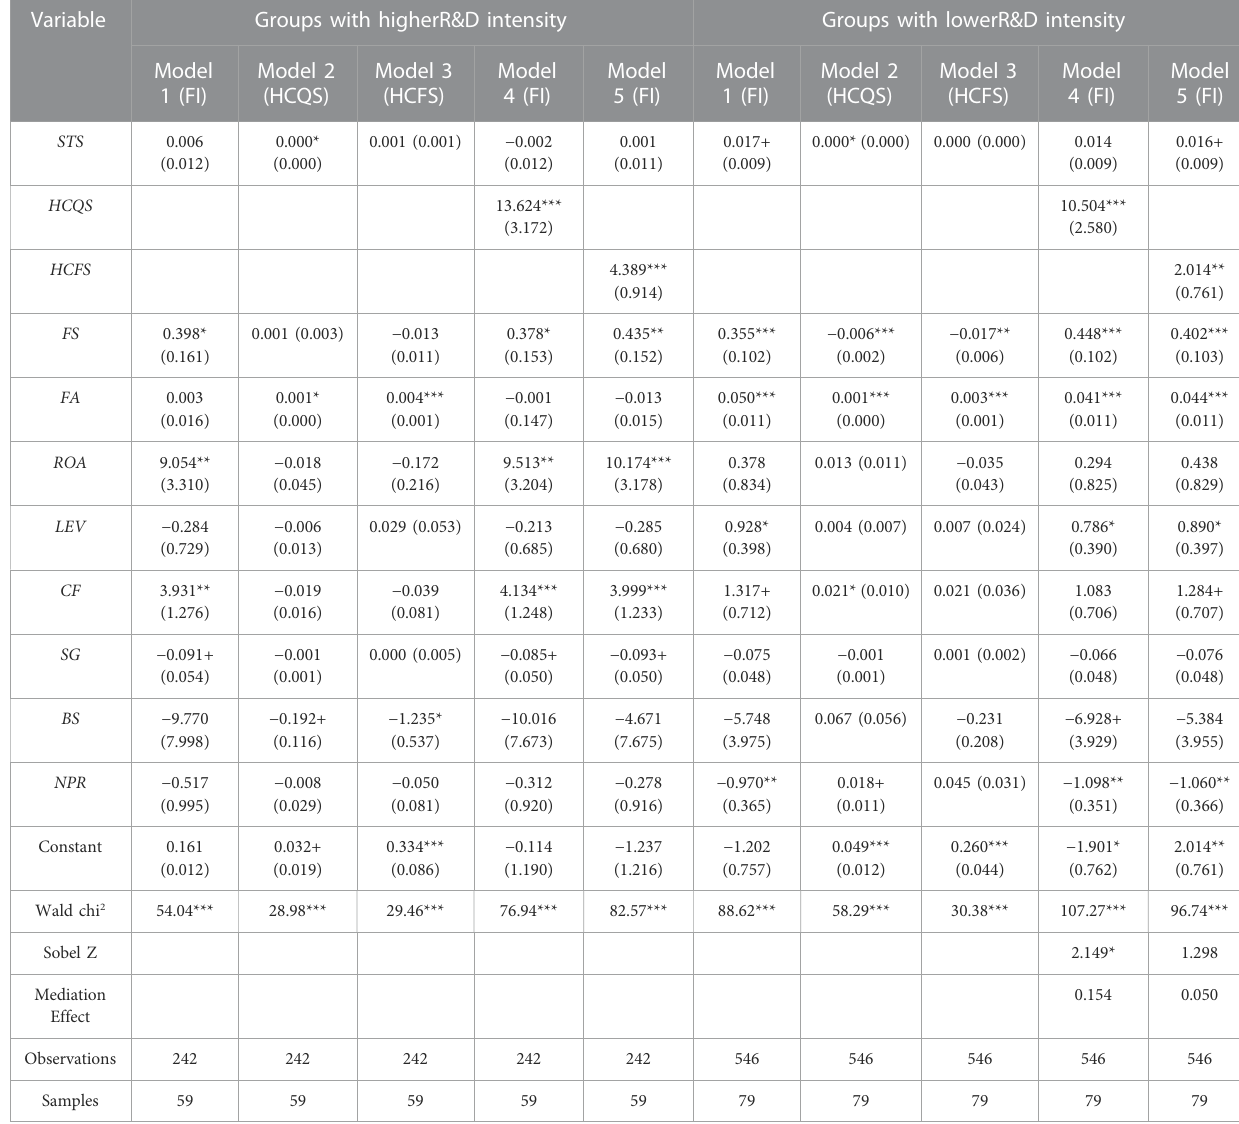
TABLE 11 Regression analysis of higher and lower R&D intensity